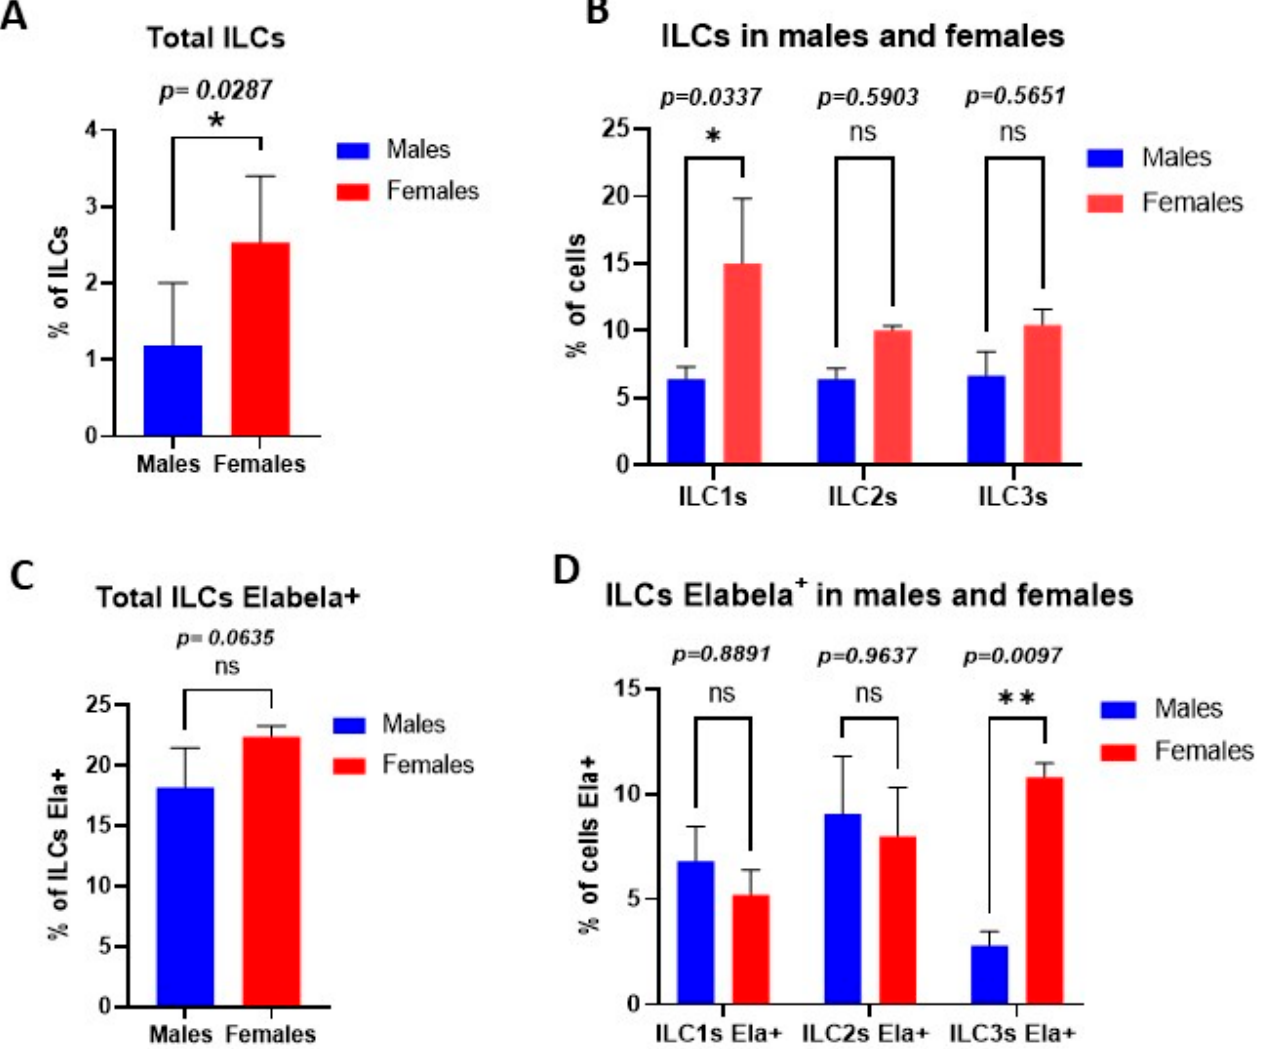
Figure 1. ILCs polarization in a sex-dependent fashion in cardiac tissues. ( A ) Percentage of ILCs among the total cells analyzed by flow cytometry. ( B ) Percentage of each class of ILCs in total ILCs, ILC1s were significantly higher in the female cardiac tissues than male counterparts. ( C ) Percentage of each class of ILCs that express Elabela; female cardiac ILC3s showed significantly higher levels of Elabela compared with male counterparts. Statistical tests: t-test followed by Mann – Whitney ( A , C ) and two-way ANOVA followed by Šidák multiple comparisons test ( B , D ). * p ≤ 0.05; ** p ≤ 0.01.